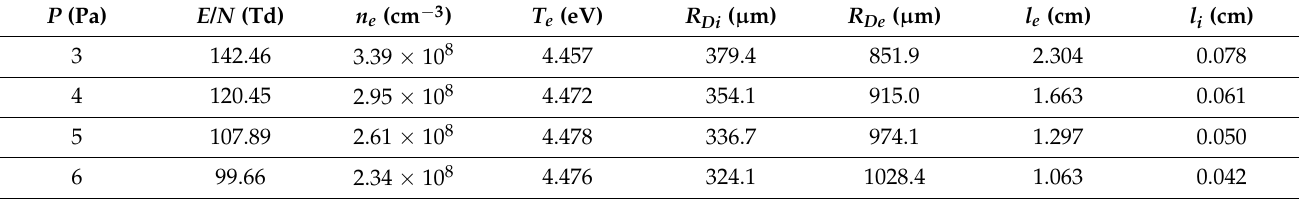
Table 1. Parameters of the RF discharge in the first series of experiments at the fixed discharge power (W in = 15 W, W out = 4.7 W) and at different